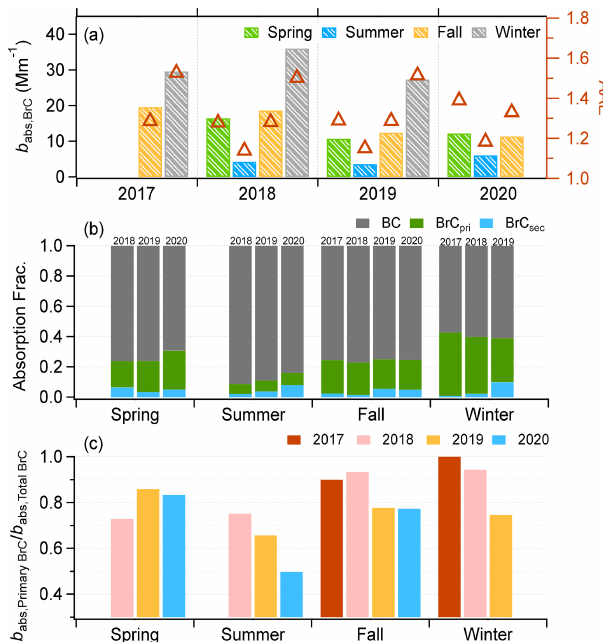
Figure 6. Seasonal variations of (a) b abs , BrC , AAE, percentage contribution of (b) absorbing components to the absorption coef- ficient, and (c) the proportion of b abs , secondaryBrC of the BrC ab- sorption coefficient at 370nm from 2018 to 2020.